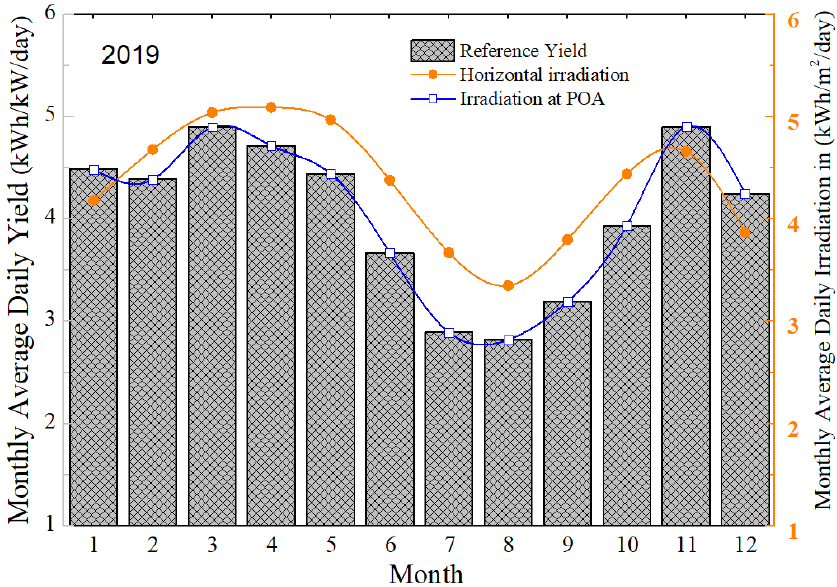
Figure 9. Reference yield compared to monthly average in-plane and horizontal daily irradiation data extracted from RETscreen Expert Viewer Software (Version 6.0.7.55, CanmetENERGY, Varennes, QC, Canada) [44].